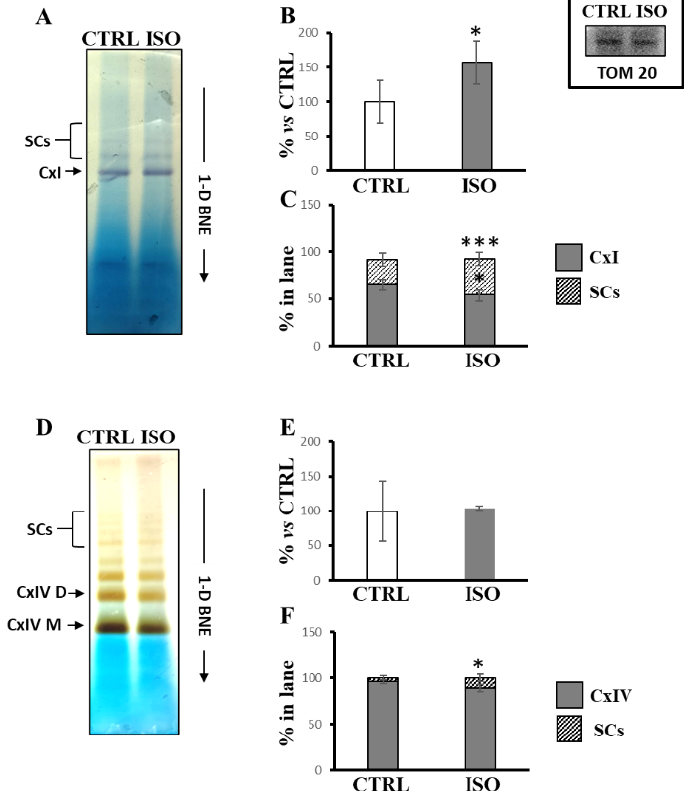
Figure 3. Isoproterenol increased the activities of complex I and complex IV in supercomplexes. The H9c2 cell cultures were incubated for 30 min in absence (CTRL) or in the presence of 1 µM isoproterenol (ISO). Mitochondrial solubilized proteins were prepared as described in Materials and Methods and separated by 1D-BNE PAGE followed by in-gel activity assay. ( A ) Representative image of in gel-activity assay for complex I. ( B ) The histograms represent the percentage value of arbitrary densitometric units (ADU) of complex I activity-stained bands of ISO treated cells with respect to CTRL cells. ( C ) The histograms represent the percentage of ADU of complex I activity-stained bands referring to free complex I (CxI) and supercomplexes (SCs) in each lane. ( D ) Representative image of in-gel activity assay for complex IV. ( E ) The histograms represent the percentage value of ADU of complex IV activity-stained bands of ISO treated cells with respect to CTRL cells. ( F ) The histograms represent the percentage of ADU of complex IV activity-stained bands referring to free complex IV (CxIV) and SCs in each lane. The values are the means ± SD of three different experiments. (ISO vs. CTRL, * p < 0.05, *** p < 0.001, Student’s t -test). In the inset, a representative image of immunoblotting with antibody against TOM20 performed for the protein loading control of CTRL and ISO samples. For other details, see under Material and Methods.